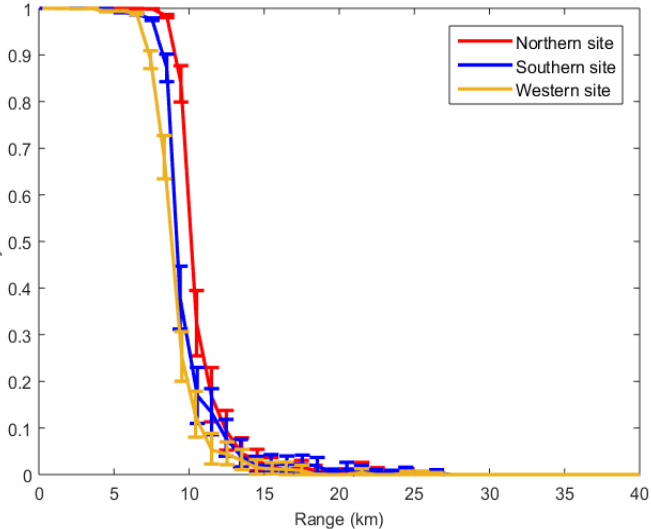
Figure 5. Estimated probability of detection curves versus range for sperm whale clicks based on Monte Carlo simulations for the 2015 dataset at the Northern, Southern, and Western sites, respectively.